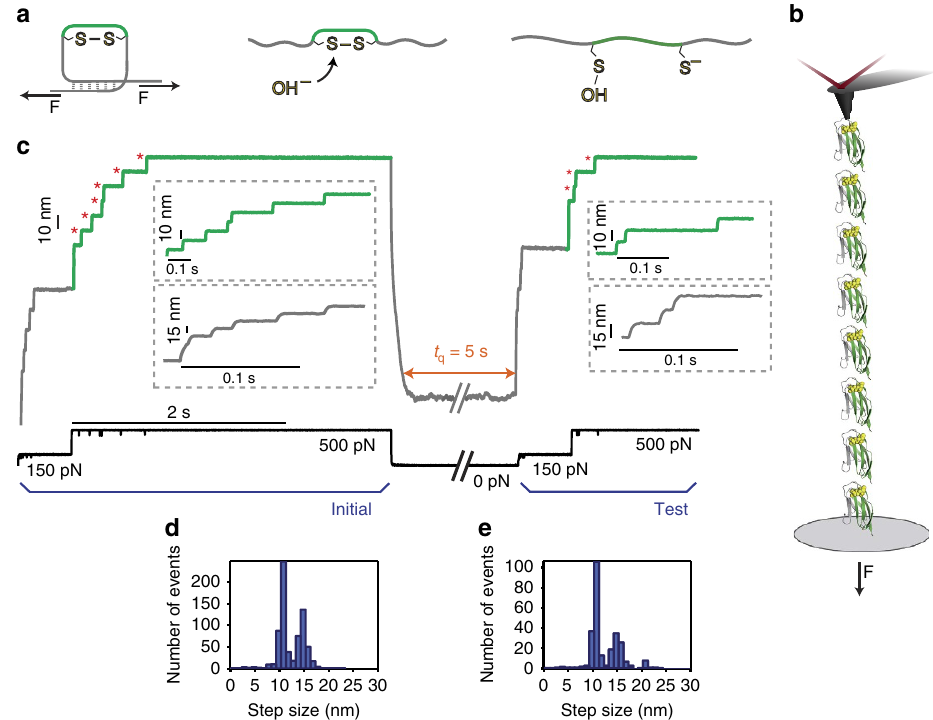
Figure 1 | Single-molecule force-clamp spectroscopy captures the non-enzymatic reformation of individual disulfide bonds. ( a ) The hydrolysis of the protein disulfide bond via a S N 2 attack by hydroxide anions results in the creation of a sulfenic acid and thiolate. ( b ) Schematics of the engineered (I27 E24C– K55C ) 8 polyprotein being stretched in the AFM set-up. ( c ) Pulling on an individual polyprotein at constant force using a specifically designed pulse-protocol captures oxidative protein folding. The initial pulse unfolds the protein and ruptures the disulfide bond; the first pulse F ¼ 150 pN unfolds and extends all the modules of the (I27 E24C–K55C ) 8 polyprotein to the mechanical clamp created by the disulfide bonds, which exposes them to the solution (grey line).